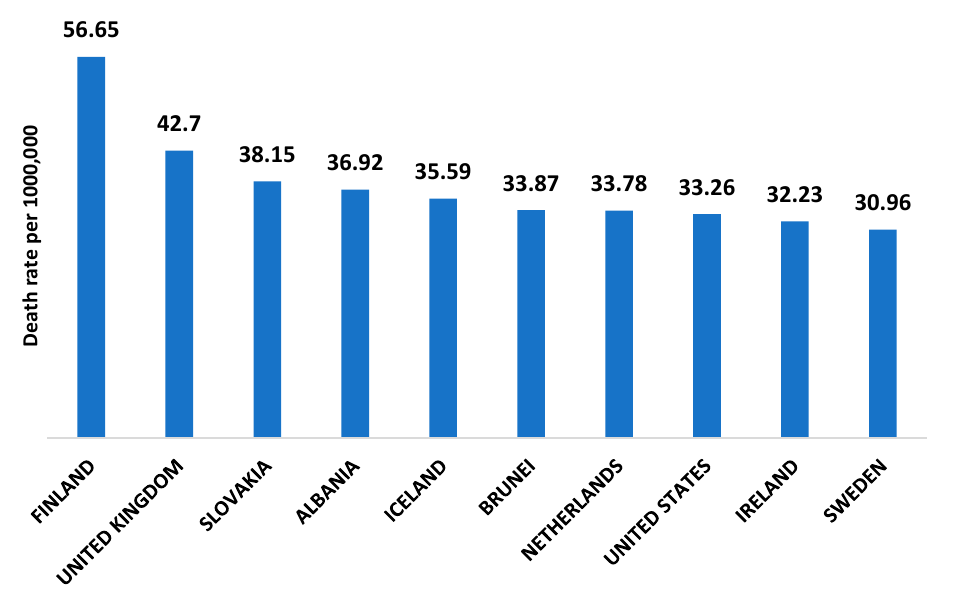
Figure 2. Top ten countries with the highest death rate due to dementia. The data is collected from the World health organization 2020, and the reported death rate is age-standardized.